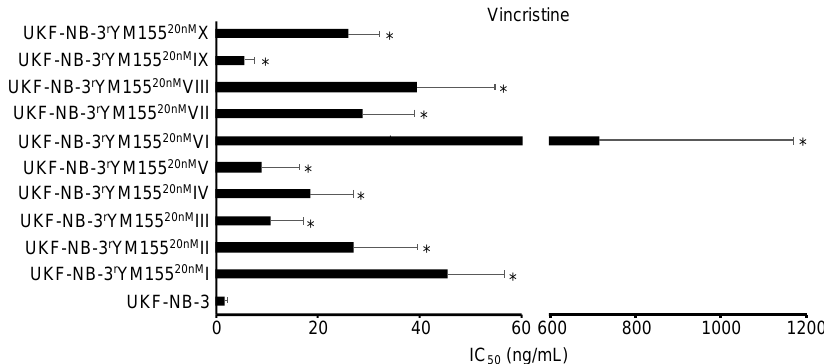
Figure 9. Vincristine concentrations that reduce cell viability by 50% (IC 50 ) were determined by MTT assay after 120 h of incubation. YM155-adapted sublines consistently displayed decreased vincristine sensitivity relative to UKF-NB-3. The vincristine IC 50 values varied considerably. * p < 0.05 relative to UKF-NB-3.